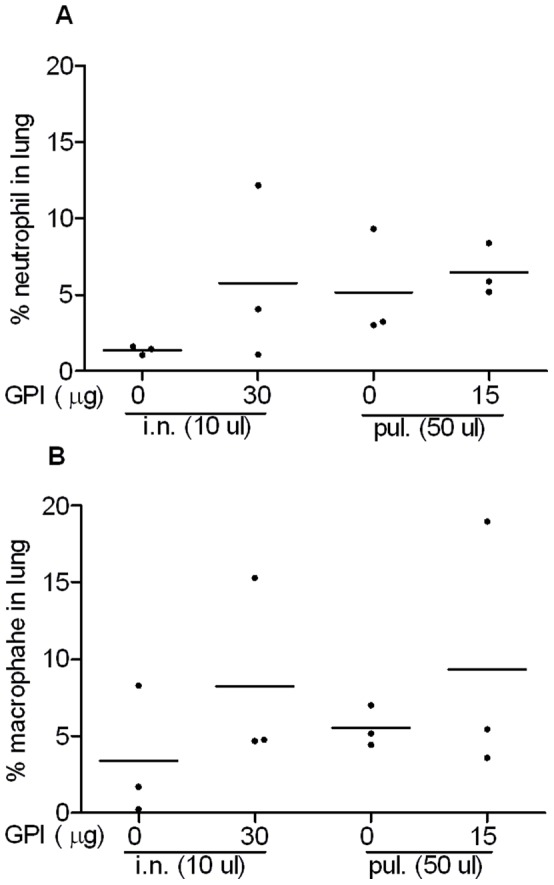
Effect of GPI-0100 on recruitment of inflammatory cells to the lung.Quantification of (A) neutrophils and (B) macrophages on micrographs as described in the legend to Figure 6. For each staining section, regions of interest (ROI) were selected using HistoQuest software. The total number of cells within the regions were defined by the nucleus staining. Neutrophils or macrophages are defined as nucleated brown cells. The results are presented as % neutrophils or % macrophages per stained sample from individual mouse.